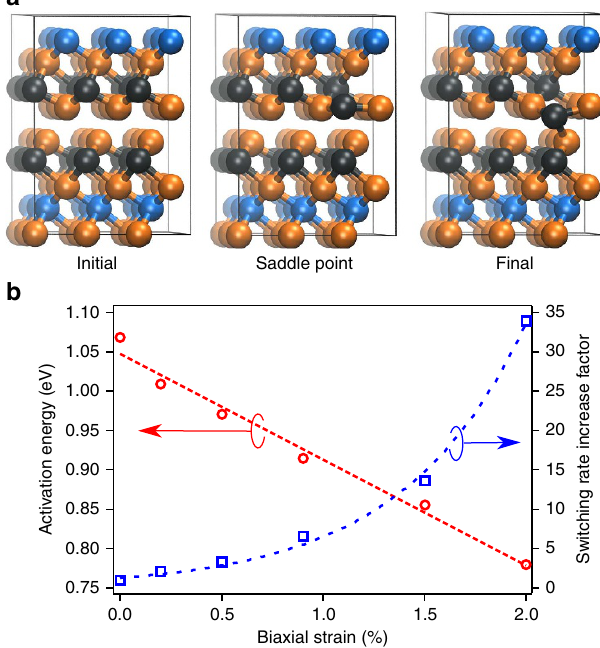
Figure 1 | The calculated activation energy for a single Ge atom to move from the GeTe layer into the van der Waals gap. ( a ) The 81 atom model at different stages of the atomic transition. The initial, intermediate saddle point and the final structures for the Ge atomic transition are shown, where Ge, Sb and Te atoms are coloured black, blue and orange, respectively. The extent to which the atoms are shaded indicates depth in the simulation cell. The black box is the periodic boundary of the simulation cell. ( b ) The activation energy (red) for the transition is plot as function of biaxial strain. The increase in switching probability at 950K relative to the unstrained superlattice is also plot as a function of biaxial strain